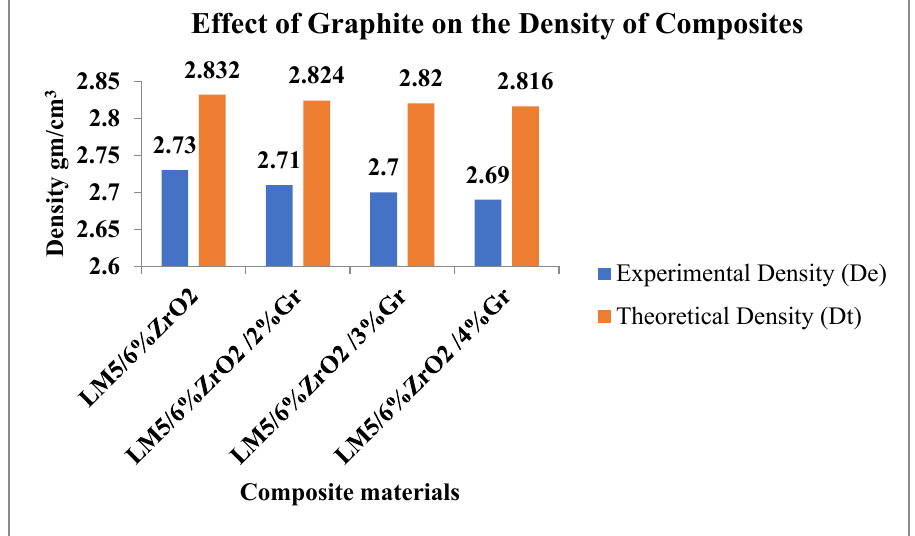
Figure 8. Effect of graphite on the density of composites.